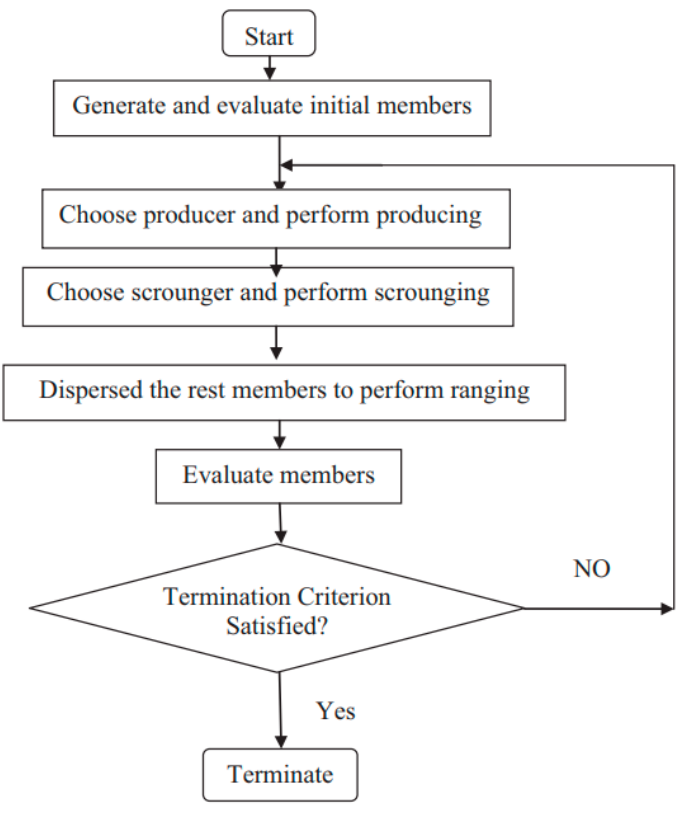
Figure 6. The general process of the OGSO algorithm